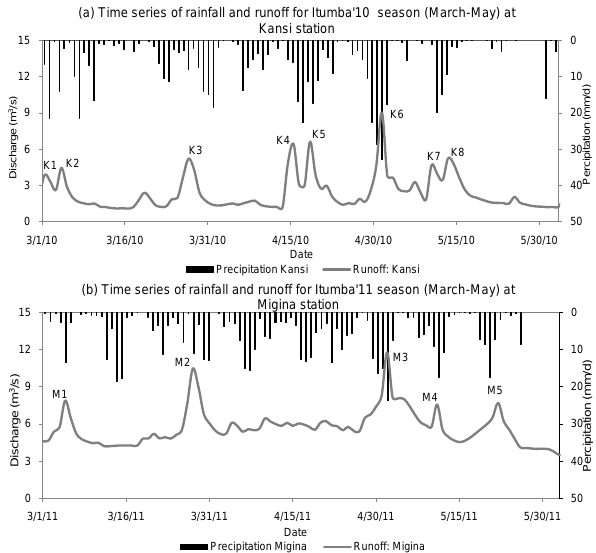
Figure 2 Time series of rainfall and runoff events during March-May 2010 at Kansi station (a) and March- Fig. 2. Time series of rainfall and runoff events during March– May 2011 at Migina station (b). May 2010 at Kansi station (a) and March–May 2011 at Migina station (b)